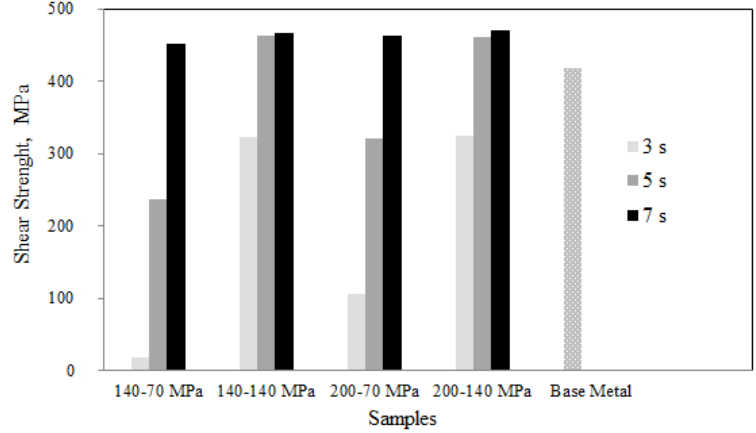
Figure 7. Shear strengths of the welded samples and base alloy.